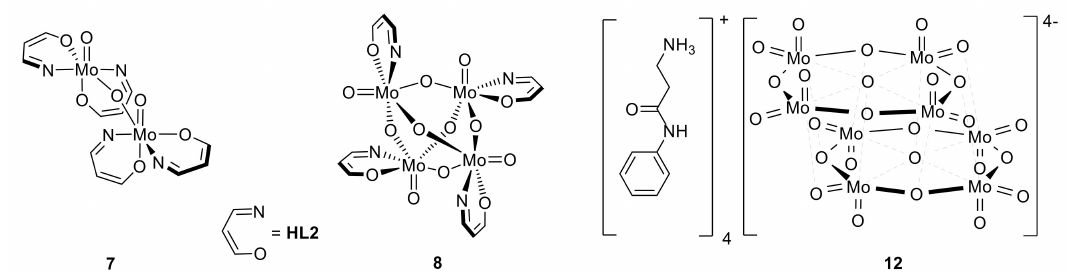
Figure 2. Polynuclear compounds 7 and 8 forming during reduction of 2 with PMe 3 , and 12 forming during reduction of 3 with PMe 3 under O 2